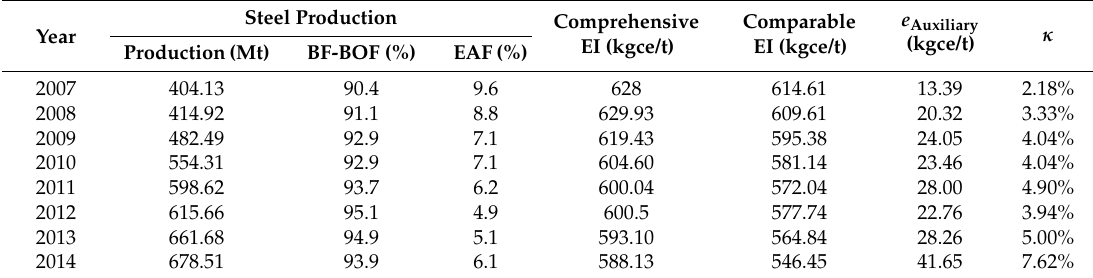
Comprehensive and comparable EIs of China’s key steel enterprises from 2007 to 2014